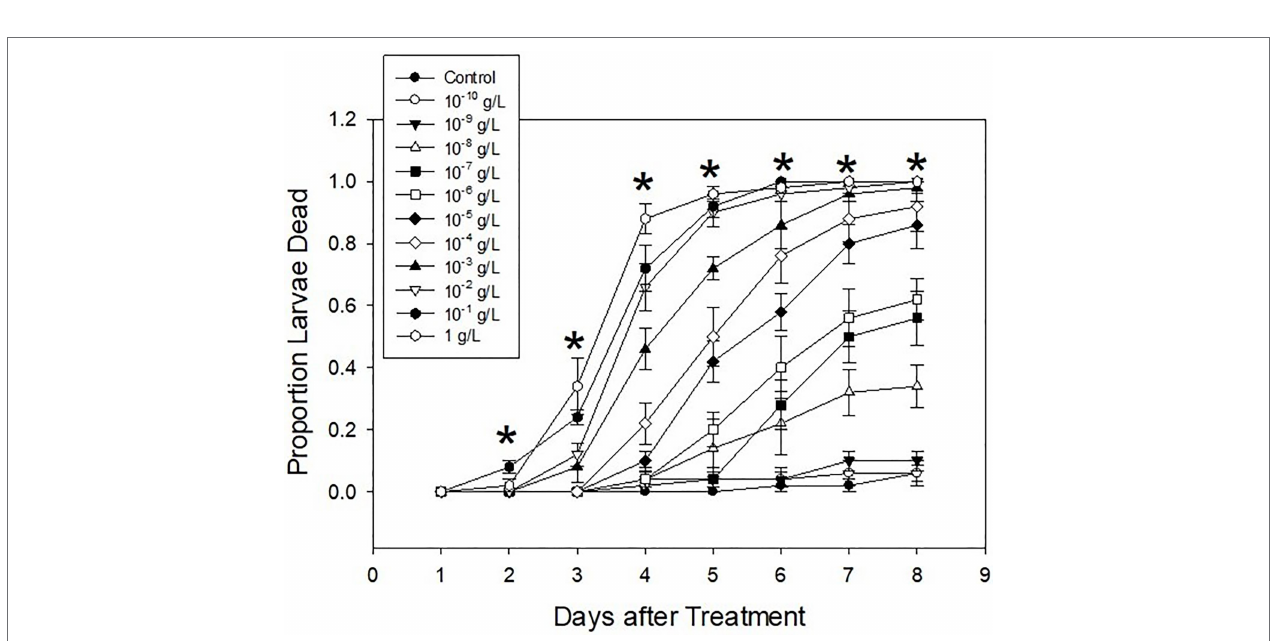
FIGURE 6 | Mean proportion of second-instar Colorado potato beetle (CPB) mortality following exposure to different concentrations of Ledprona [or dsGFP (Control)] on different days of the experiment. Error bars denote standard errors. Asterisks indicate the dates when differences among the treatments were significant ( p <